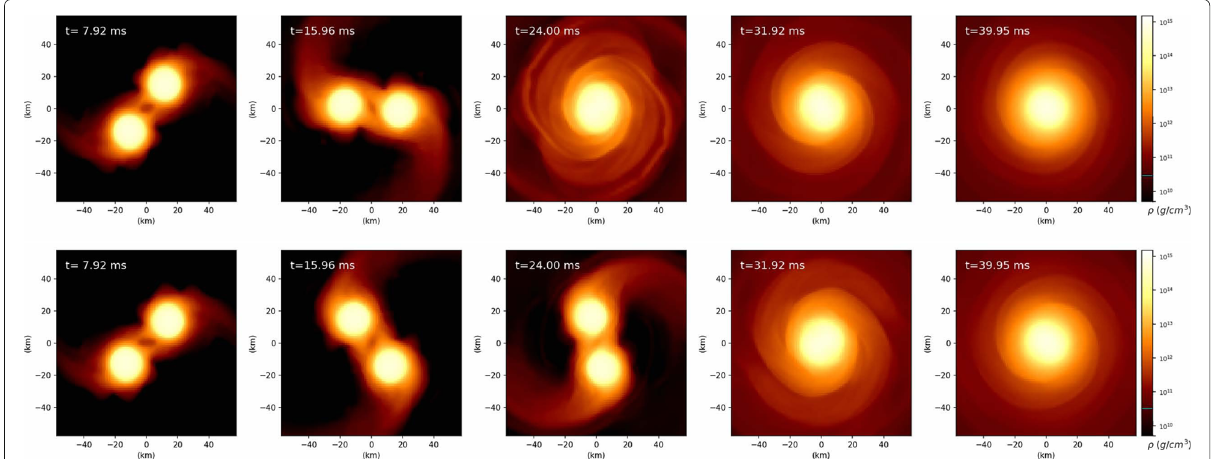
Fig. 14 Matter density evolution of BNS mergers with equal mass 1.5 M (cid:3) with (a) n 1 / 2 = 2 n 0 (the upper row) and (b) n 1 / 2 = 3 n 0 (the lower row)